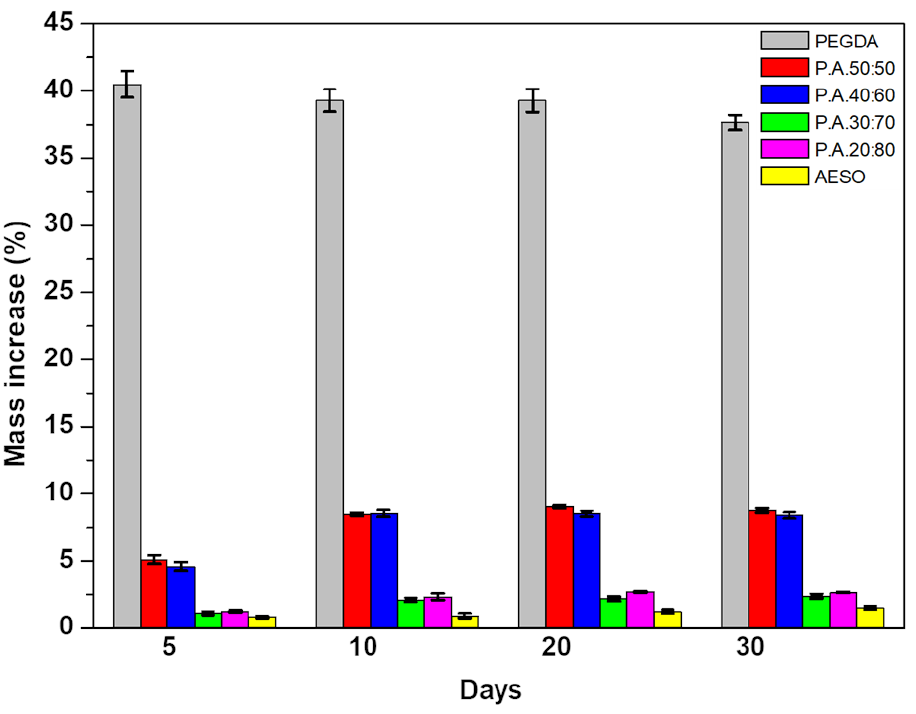
Figure 8. Swelling behavior of 3D-printed parts for 5, 10, 20, and 30 days with different AESO load- ings.